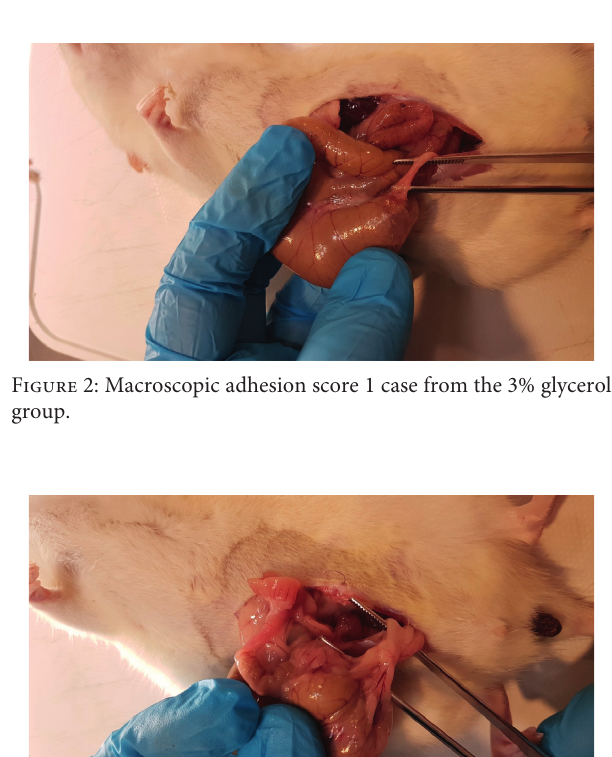
Figure 1: Macroscopic adhesion score 0 case from the 3% glycerol plus 3% sodium pentaborate group.